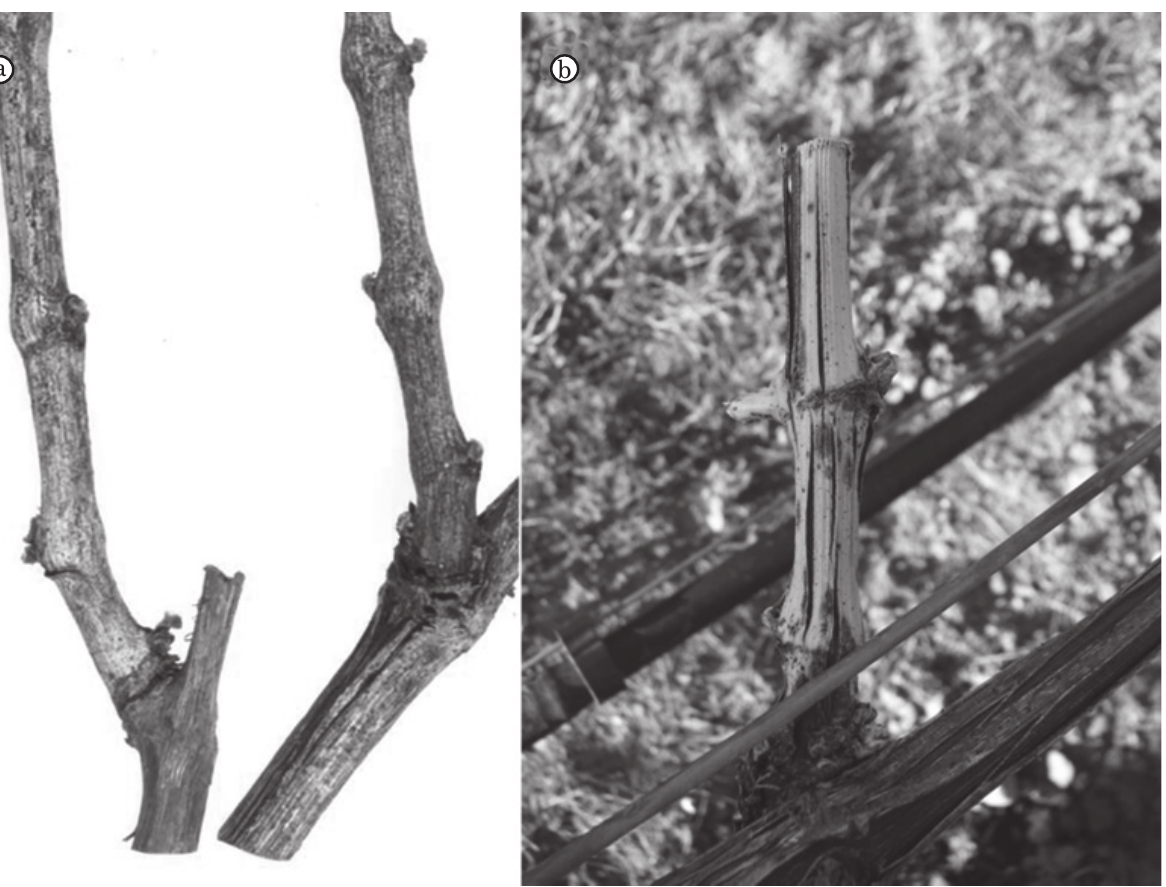
Figure 4. a–b. Grapevine canes with bleached appearance characteristic of excoriose symptoms. (Picture a courtesy of A.J.L. Phillips, Faculdade de Ciências e Tecnologia, Universidade Nova de Lisboa, Quinta da Torre, Caparica,